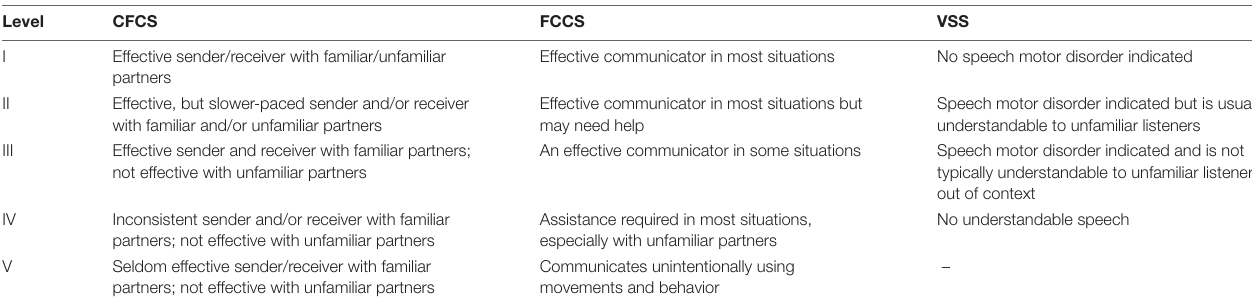
TABLE 1 | Descriptors for levels of the CFCS, FCCS, and